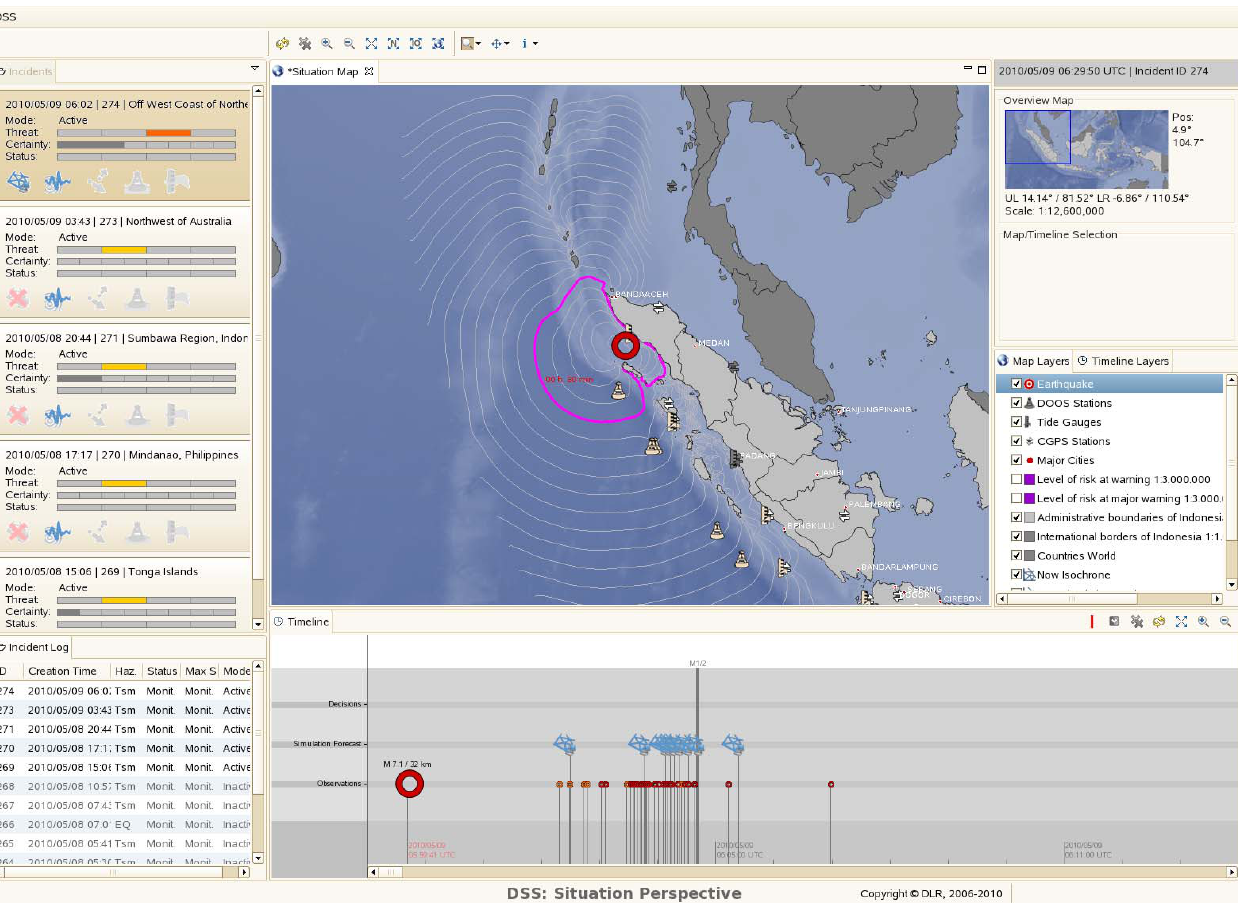
Fig. 4. Situation Perspective (overview of the situational picture). The map shows wave propagation isochrones with the EQ location shown as a red circle inside them. The operator can chose among all “incidents”, in order to display all data relevant to that incident. Each incident contains the aggregated information about its individual threat, certainty and status. A timeline on the bottom depicts the situational picture as it evolves in the course of time (which sensor observation is expected to be received next, which coastal warning segment is expected to be hit at what time